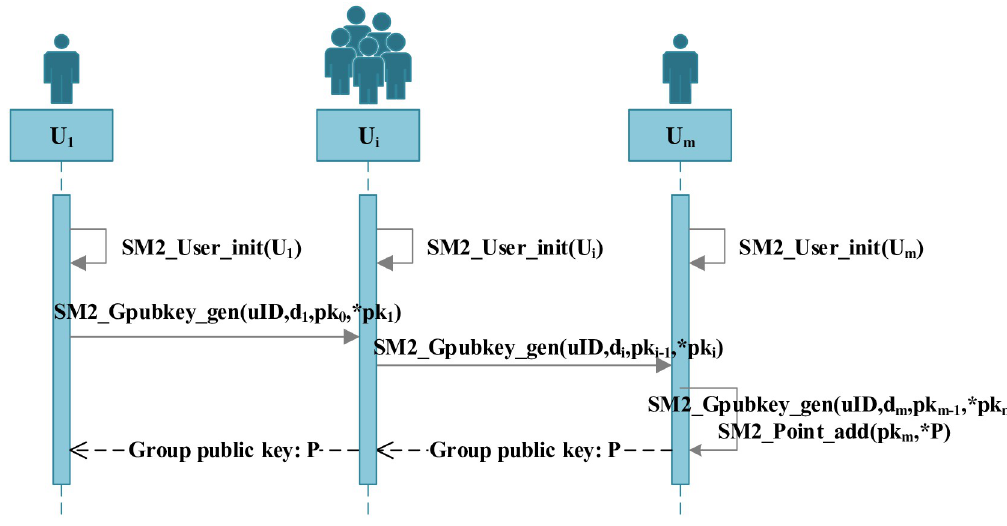
Fig 4. Key generation timing